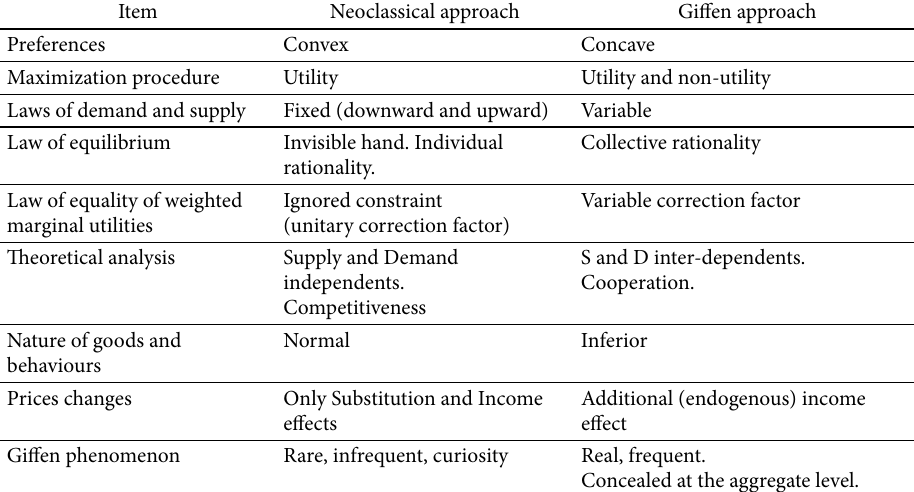
Table 1. Redefining laws of market and others basic economic